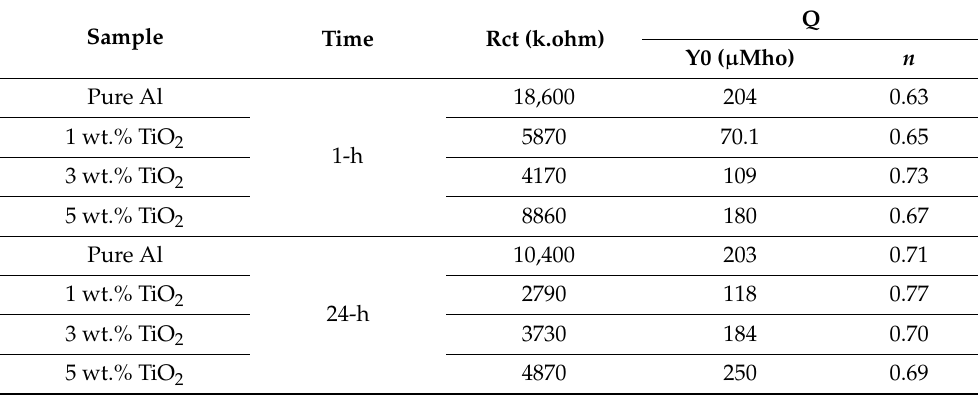
Figure 8. Graphical representation of Rct obtained after 1 h and 24 h exposure to NaCl solution. Table 1. Obtained parameters after EIS experiment on the composite samples with exposures of 1 h and 24 h in 3.5% NaCl solutions.